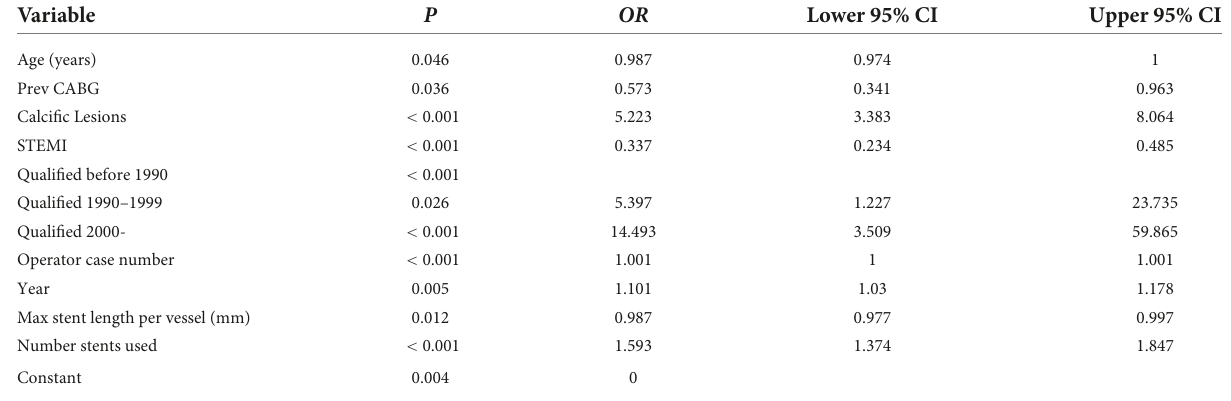
TABLE 2 Multivariate analysis of IVUS